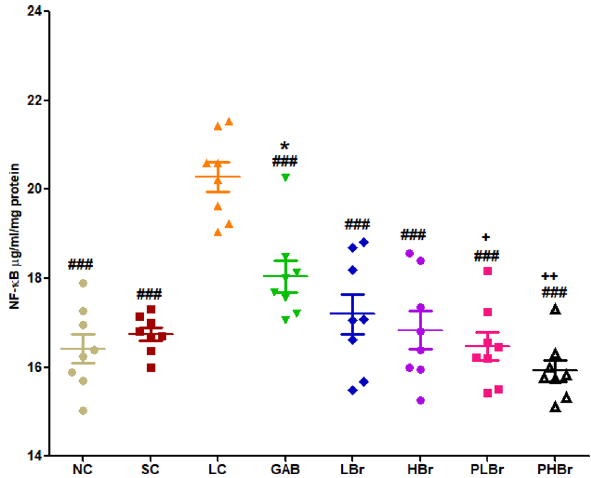
Figure 7. Effect of bromelain on sciatic nerve nuclear factor kappa-light-chain enhancer of activated B-cells (NF-kB). Bromelain reduced NF-kB in the chronic constriction injury model of neuropathic pain. Each values represent mean ± SEM of each group (n = 8). # p < 0.05, ## p < 0.01, ### p < 0.001 compared with ligated control; *p < 0.05, **p < 0.01, ***p < 0.001 compared with normal control; + p < 0.05, ++ p < 0.01, +++ p < 0.001 compared with reference control. NC Unligated Normal Control, SC Sham Control, LC Ligated Control, GAB Gabapentin Reference Control (30 mg/kg gabapentin), LBr Low Dose Bromelain (30 mg/kg), HBr High Dose Bromelain (50 mg/kg), PLBr Pre-treated Low Dose Bromelain (30 mg/kg), PHBr Pre-treated High Dose Bromelain (50 mg/